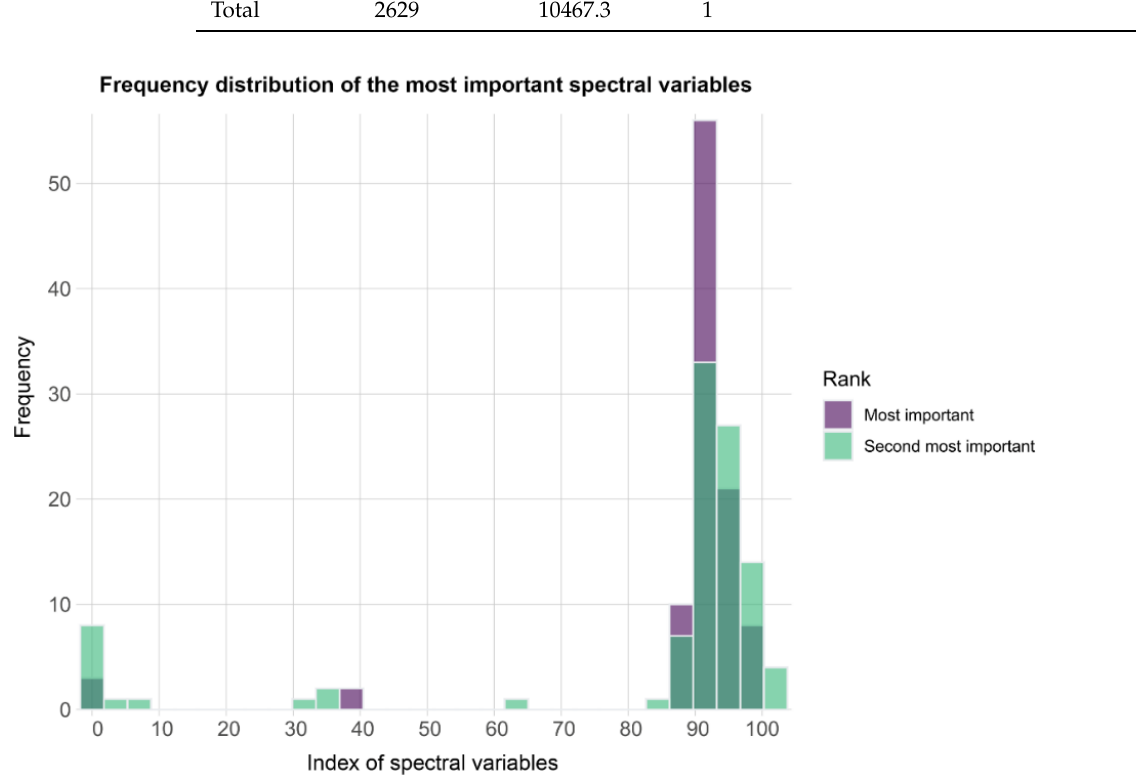
Figure 9. Frequency distribution of the most (violet) and second most (green) important variables in the ML models for the 100 iterations of the cross-pots predictions. The x -axis of the plot ends at 104 since this was the maximum spectral band sampled as the two most important predictor variables in the 100 iterations.